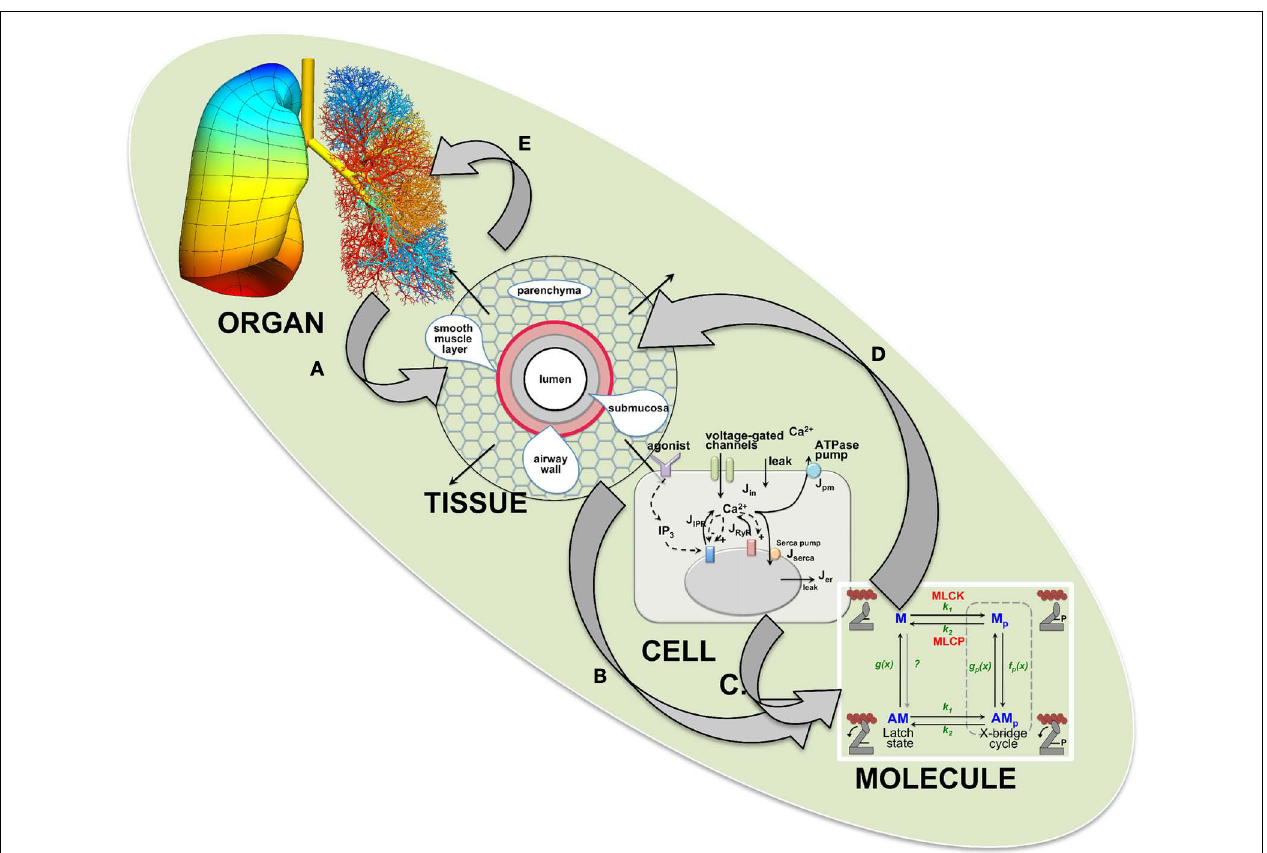
tethering, (B) Shortening velocity that is limited by the balance of active and passive forces, (C) Coupling of calcium to force generation via activation of MLCK, (D) Active and passive force generation from cross-bridges and cross-linkers, (E) Airway constriction and redistribution of